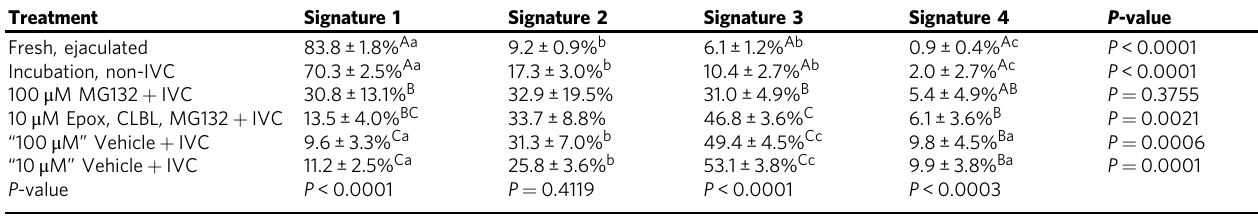
Table 2 Effect of proteasomal inhibition on zinc signature Treatment